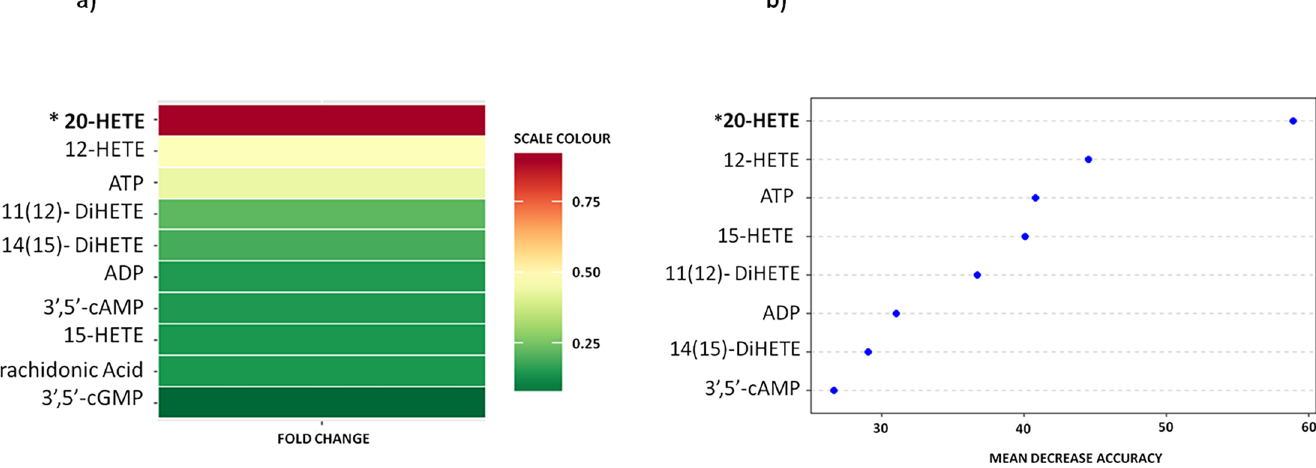
Table 2. Correlations between the levels of 20-HETE and clinical parameters.